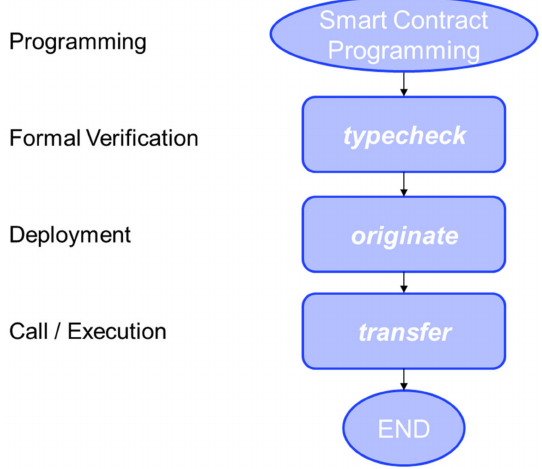
Figure 2. Tezos Smart Contract Workflow.